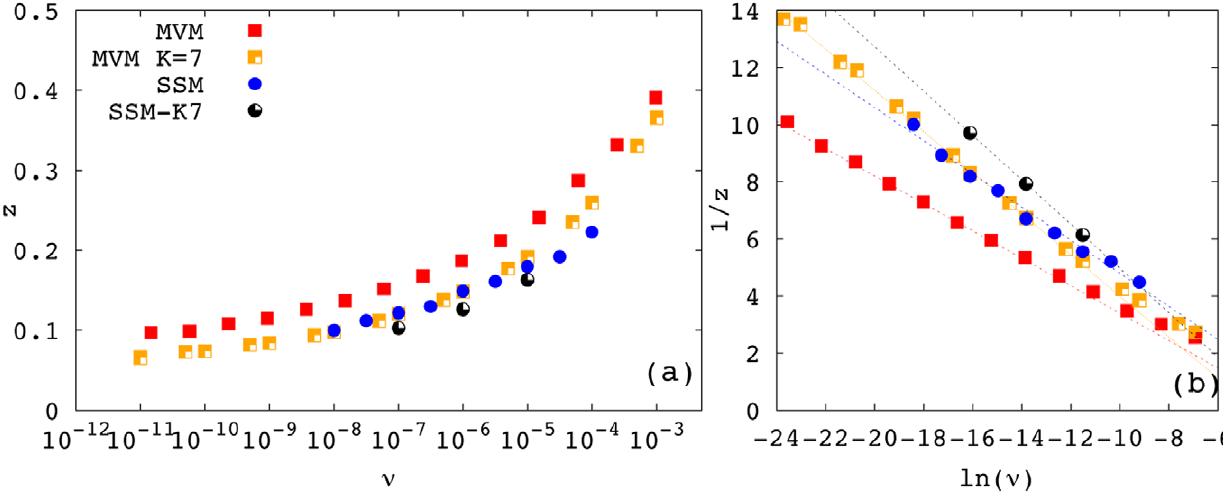
Figure 2. Exponent z as a function of v for the MVM and SSM. Panel (a) shows z vs v for MVM and SSM with NN- and square-kernel with K =7. The SSM is simulated for M =100 and m ~ 0 : 1 . Due to computational limitation, simulations for the SSM at K =7 have been performed at three different values of v only. The system size has been chosen in each simulation in order to properly resolve the power-law regime. Panel (b) shows 1/ z vs ln( n ) for the same data of (a). Dotted straight lines are best fits obtained using Eq. (2). Fitted values are: for the NN-kernel MVM m & { 0 : 48 q & { 1 : 4 and SSM m & { 0 : 58 q & { 1 ; for the square-kernel K =7 MVM m & { 0 : 72 q & { 3 : 2 and SSM m & { 0 : 78 q & { 2 : 8 .